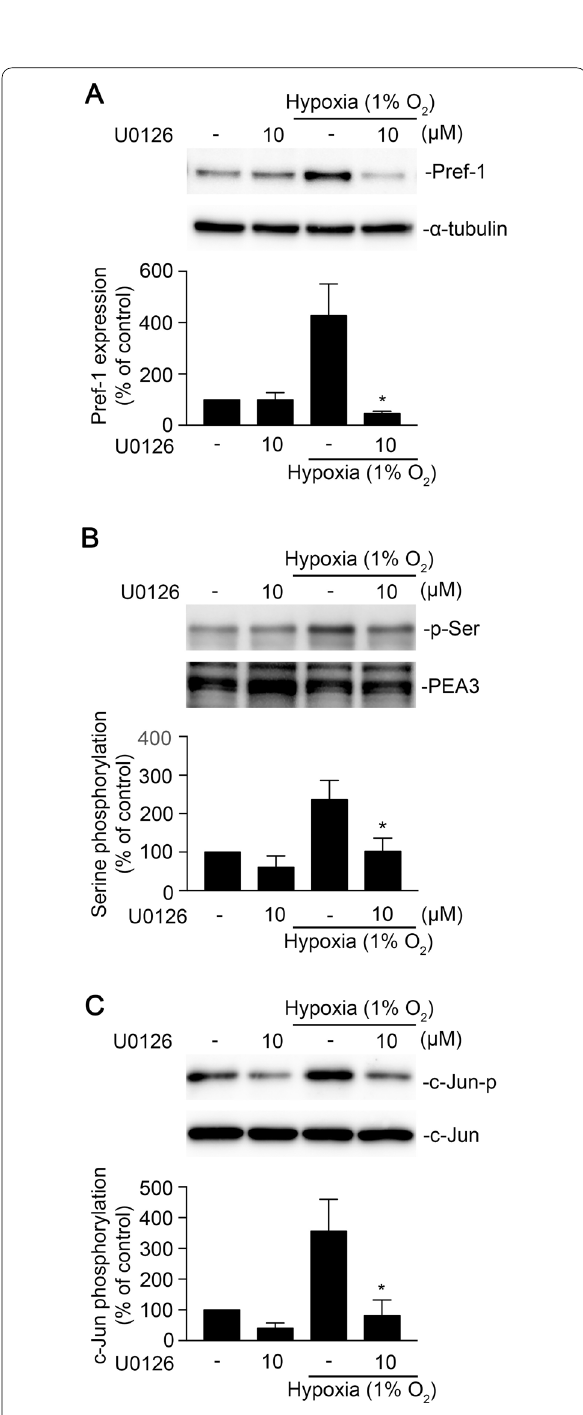
Fig. 4 Involvement of ERK in hypoxia induces a Pref‑1 expression in WI‑38 cells. A WI‑38 cells were pretreated with U0126 for 30 min and then incubated with the hypoxia (1% O 2 ) for 4 h. Levels of Pref‑1 and α‑tubulin in cell lysates were determined. Data are presented as the mean S.E.M. of three experiments. * P < 0.05, compared with ± the hypoxia‑exposed group. Cells were pretreated with U0126 for 30 min and then subjected to hypoxia (1% O 2 ) for 30 min. B PEA3 was immunoprecipitated using anti‑PEA3 antibody, and PEA3‑p‑serine was detected using anti‑p‑serine antibody. The quantified results were adjusted with PEA3 and expressed as a percentage of control. C Levels of phospho‑c‑Jun Ser63 and c‑Jun were detected using Western blotting in cell lysates. Values represent the means S.E.M. ± of three experiments. * P < 0.05 compared with the hypoxia‑exposed group